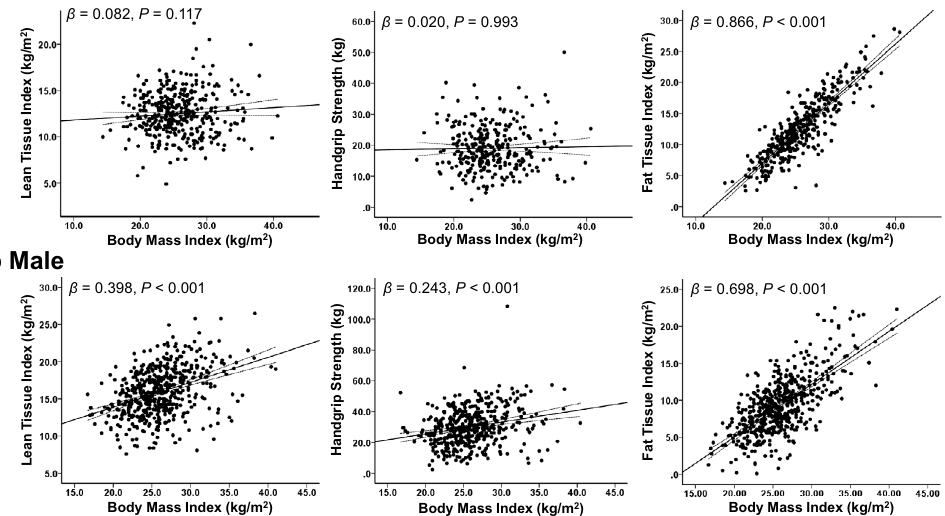
Figure 1. Correlations between body mass index, body composition, and handgrip strength. ( a ) In females, body mass index (BMI) was positively related to fat tissue index (FTI); however, it was not correlated with handgrip strength (HGS) or lean tissue index (LTI). ( b ) HGS, LTI, and FTI were positively correlated with BMI in